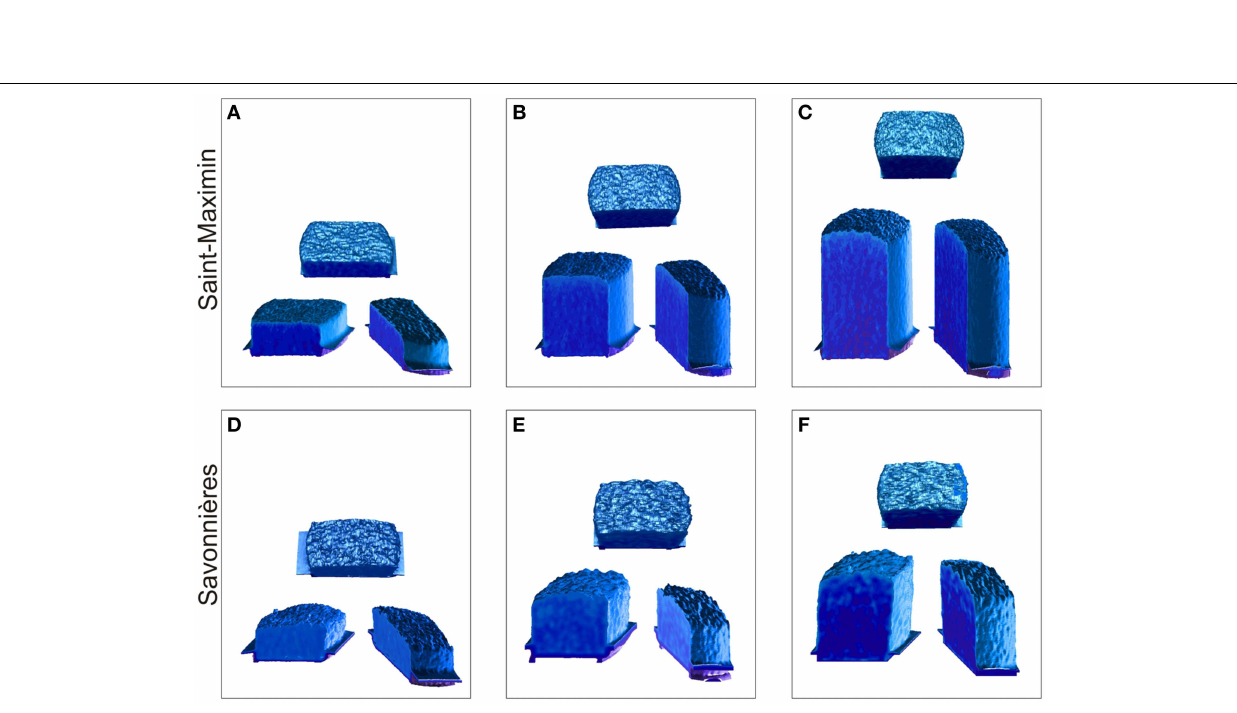
Frontiers in Physics |